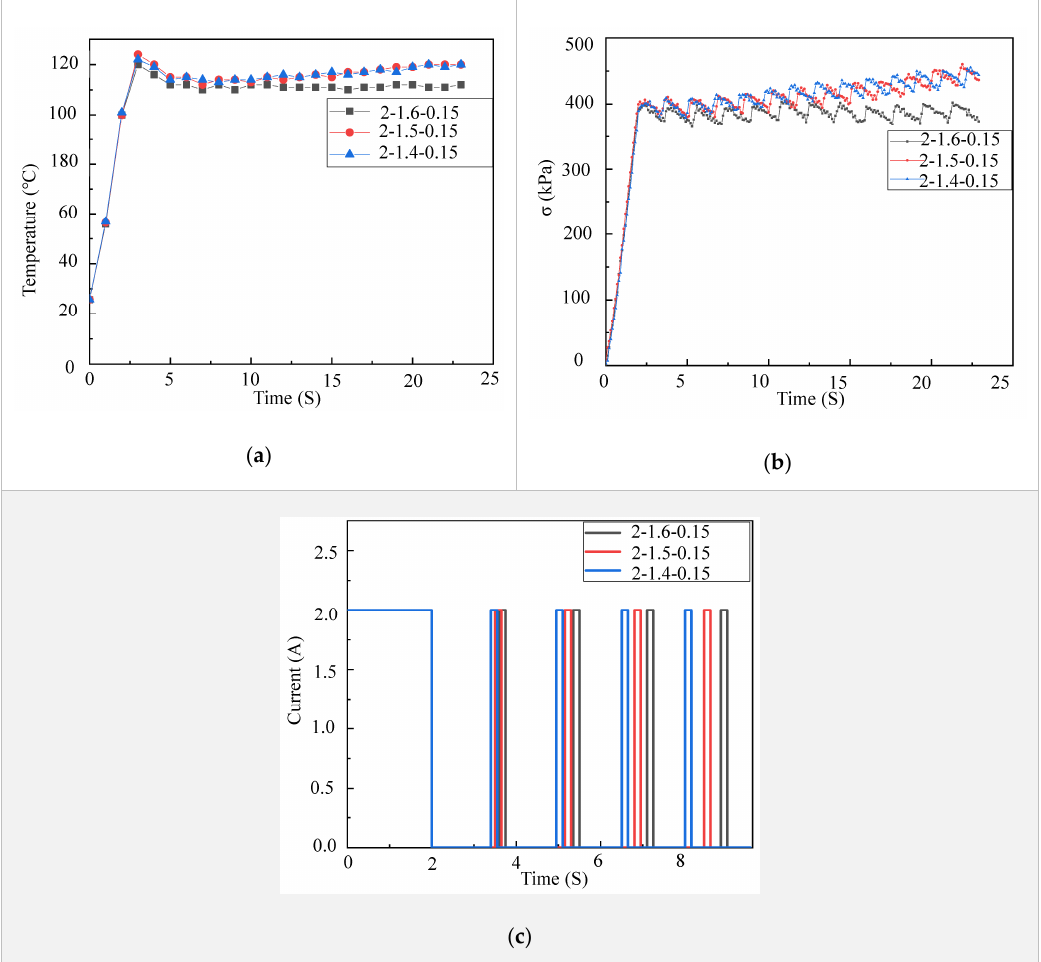
Figure 2. Characterization of LCE tendon. ( a ) Experimental setup for LCE tendon characterization. ( b ) Temperature dis- tribution and length change of an LCE tendon at the initial state (left, room temperature) and full contraction state (right, heated). ( c ) The LCE tendon surface temperature versus time during joule heating due to different electric currents. ( d ) The maximum contraction strain can be reached in LCE tendons at different electric currents. ( e ) The contraction stress in LCE tendon versus heating time.